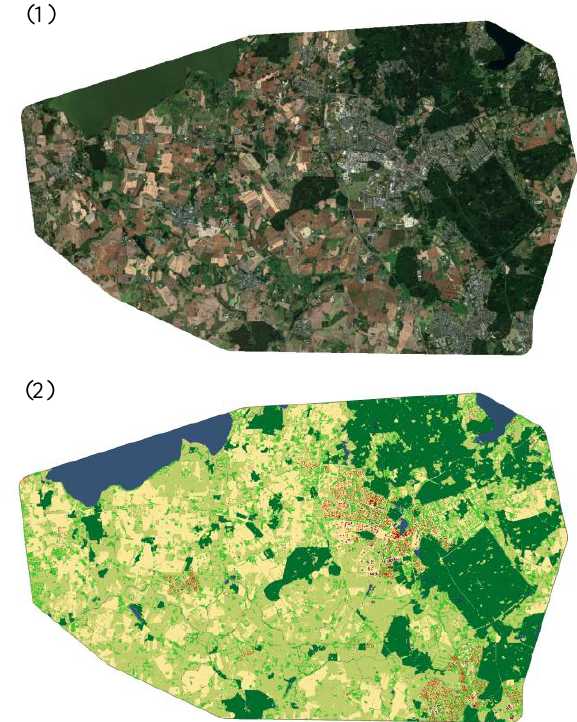
Figure 10: (1) Sentinel-2 L2A cloud-free mosaic over Hillerod, Denmark, and (2) corresponding 6-class land-cover map: water (blue), grass (light green), tree/forest (dark green), residential building (red), industrial/commercial building (orange) and barren